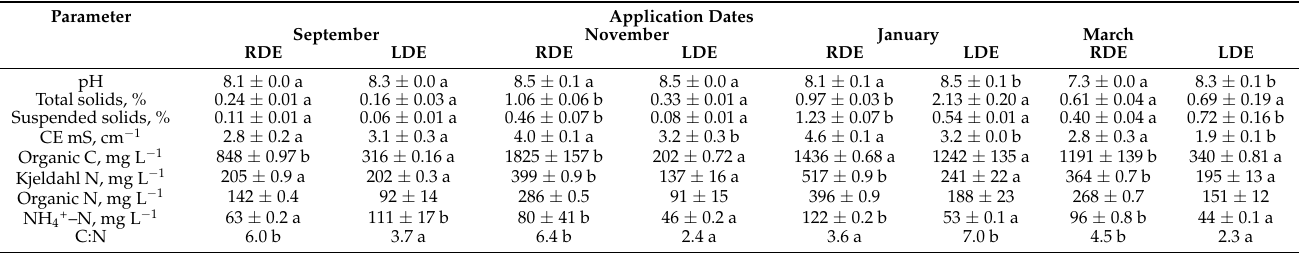
Table 1. Characterization of Raw dairy effluent (RDE) and Lagoon dairy effluent (LDE) applied to pots with fescue pasture (mean n = 3 ±